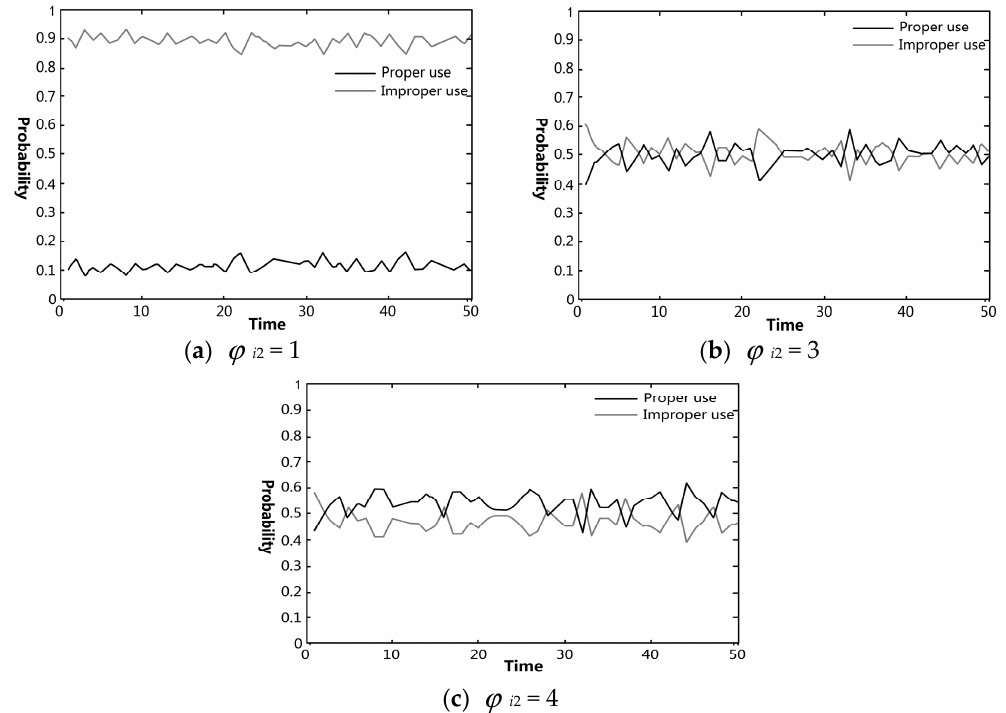
Figure 3. Simulation results of the changes of farmers’ behavioral choices regarding VA use under the variation of their knowledge about hazards of VA residues: ( a ) the value of ϕ i 2 (knowledge of hazards of VA residues) was set to 1; ( b ) the value of ϕ i 2 was set to 3; ( c ) the value of ϕ i 2 was set to 4.